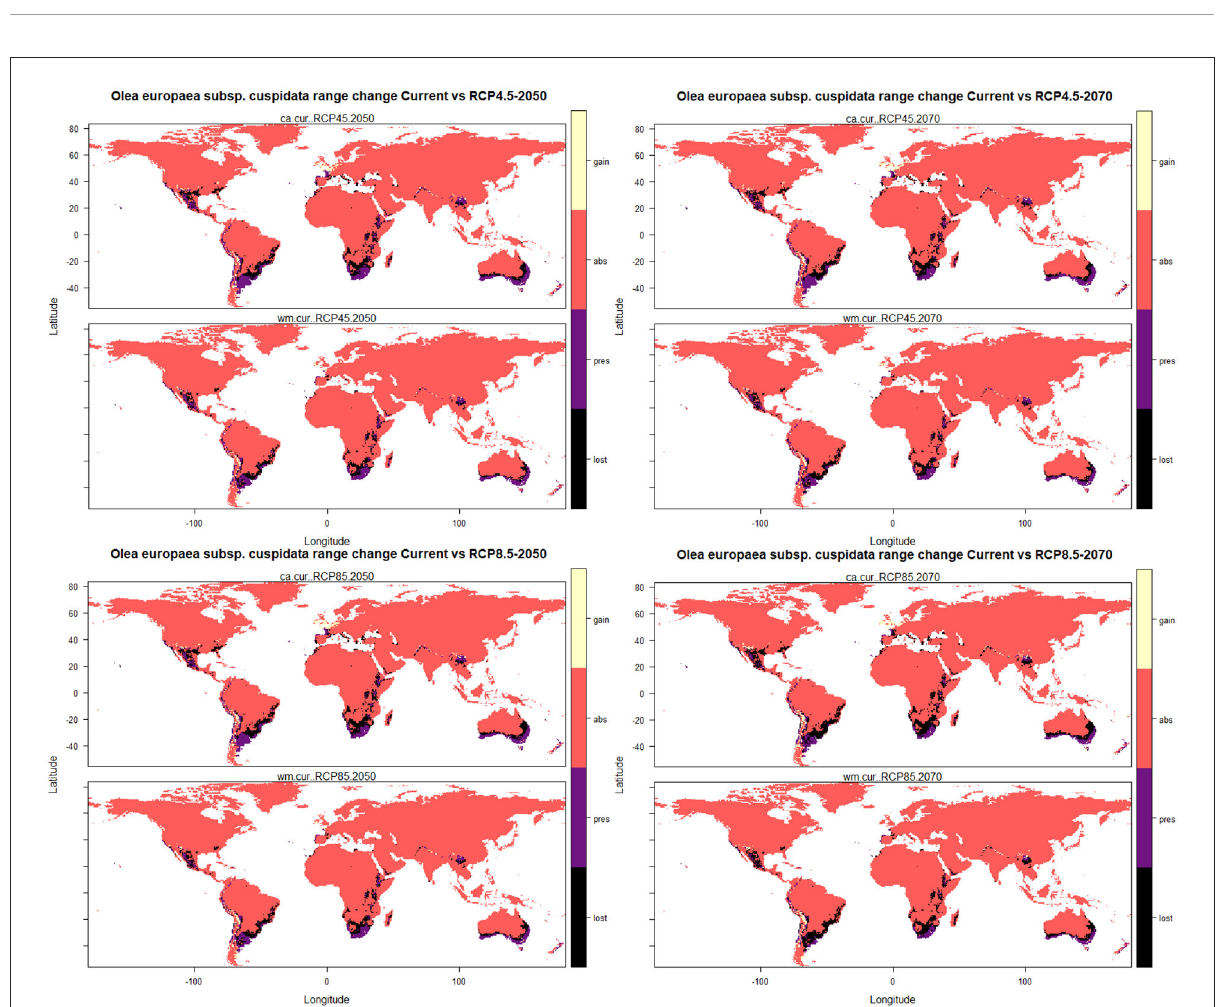
FIGURE4 Plots of the predicted range changes for Olea europaea subsp. cuspidata between current and future climatic conditions.